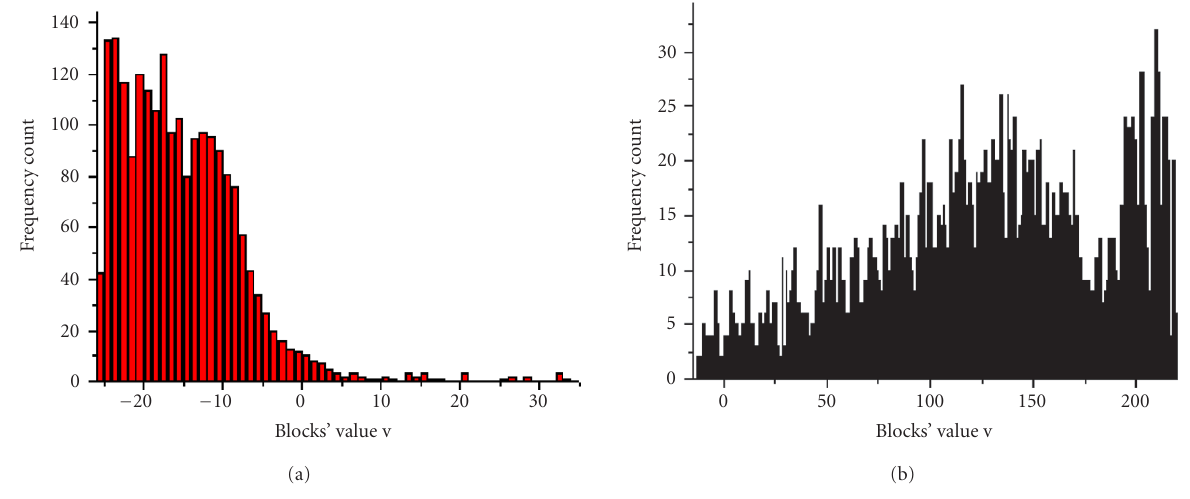
Figure 23: The value of the (a) background and (b) foreground class in linear classification in FVC2002 DB1.